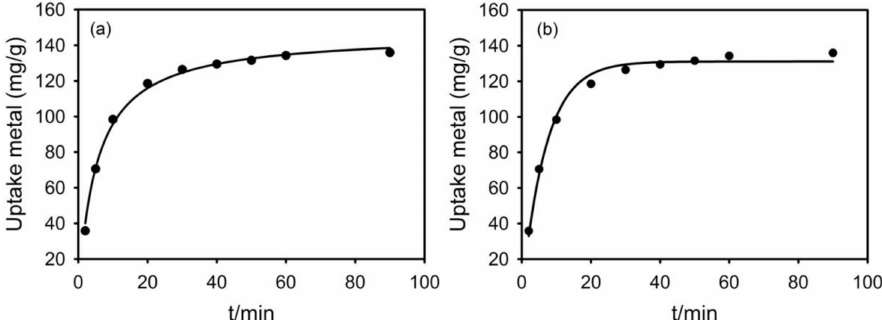
Figure 13. ( a ) The pseudo-second-order kinetic model, ( b ) the pseudo-first-order kinetic model for the adsorption of Pb(II) by g-PAM/OVerm (Reaction conditions: initial suspension pH = 5.5, 0.05 g g-PAM/OVerm, T = 30 ◦